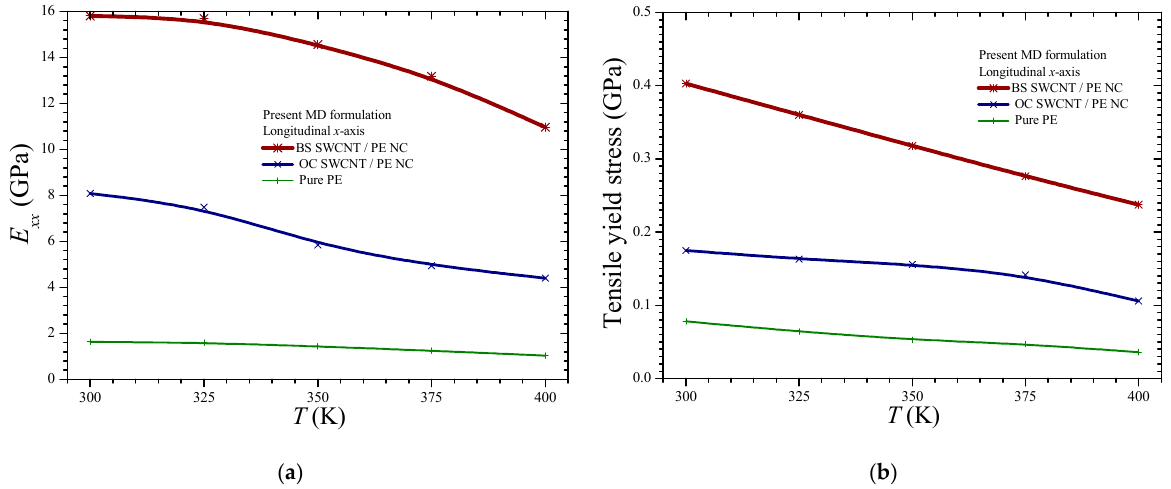
Figure 10. The temperature dependence of the longitudinal ( a ) stiffness coefficient and ( b ) tensile yield stress provided by the three materials.